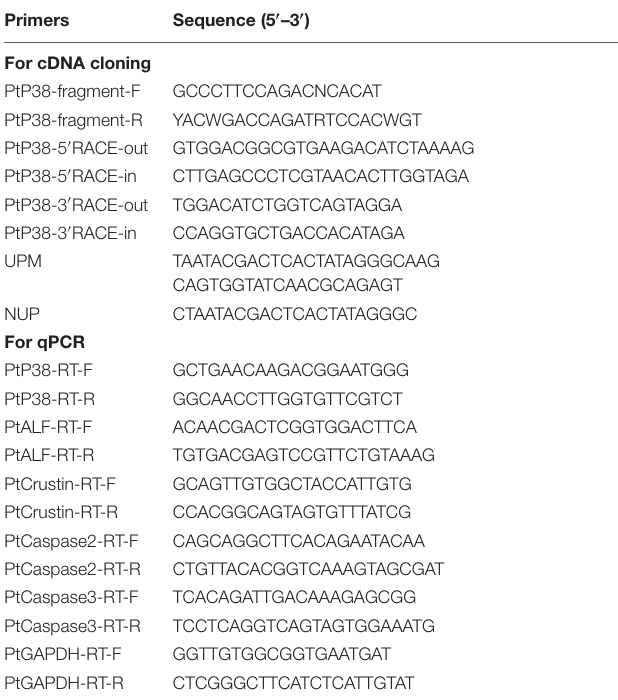
TABLE 1 | Sequences of the primers used in this